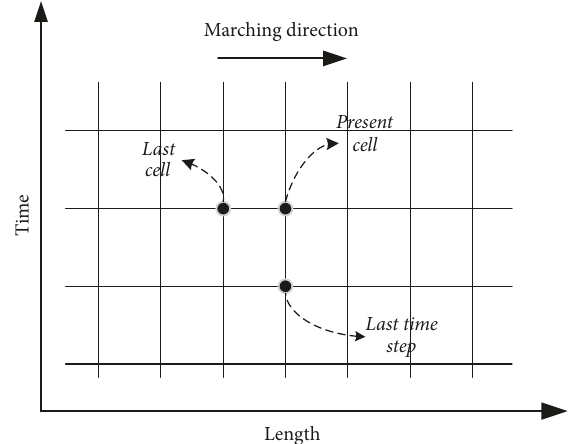
a function of temperature and pressure. Solid line represents the results from present calculations and symbols represent the results from